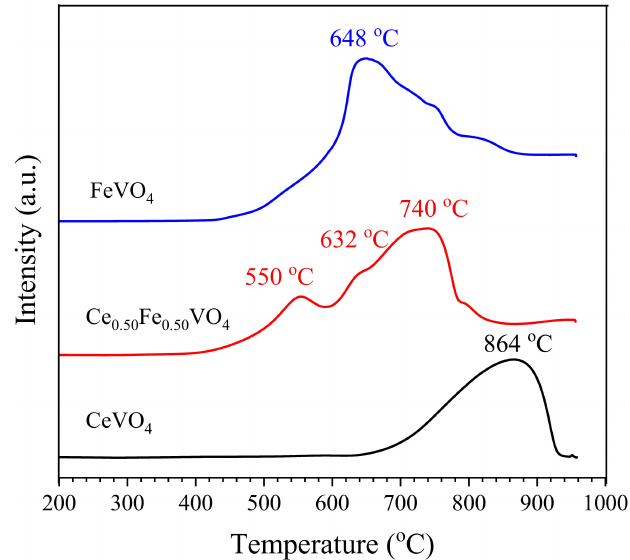
Figure 10. H 2 -TPR profiles of the catalysts.